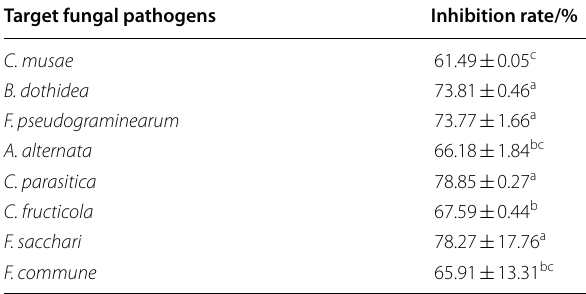
Table 1 Antifungal activity of strain Gxun-6 against eight plant pathogenic